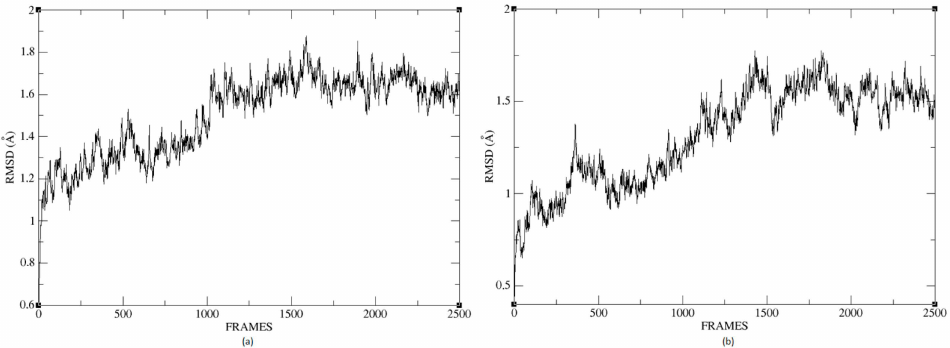
Figure 26. RMSD of the protein backbone during simulation of MD trajectories, ( a ) for the protein related to Ligand 1, and ( b ) for the protein related to Ligand 2.